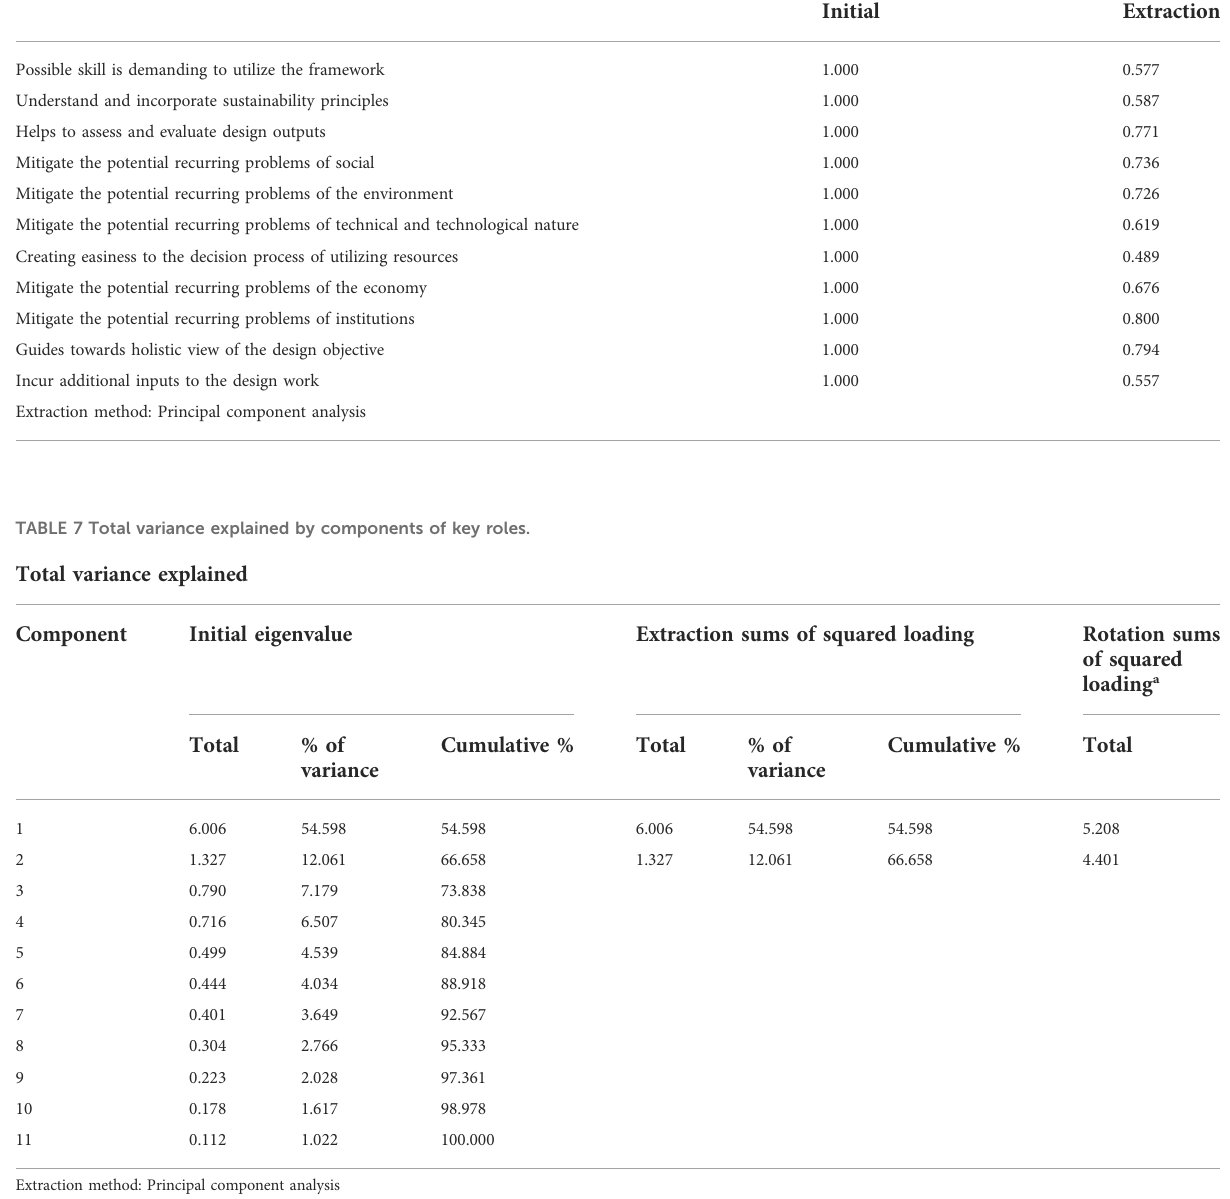
Initial Extraction